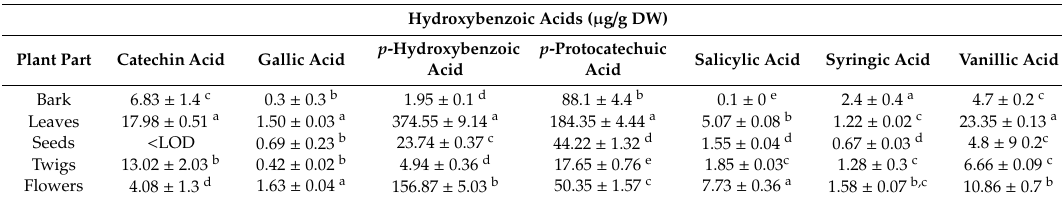
Table 4. Quantity ( µ g / g DW) of hydroxybenzoic acids in 80% methanol Protea ca ff ra extracts. Values represent mean ± standard error, n = 3.